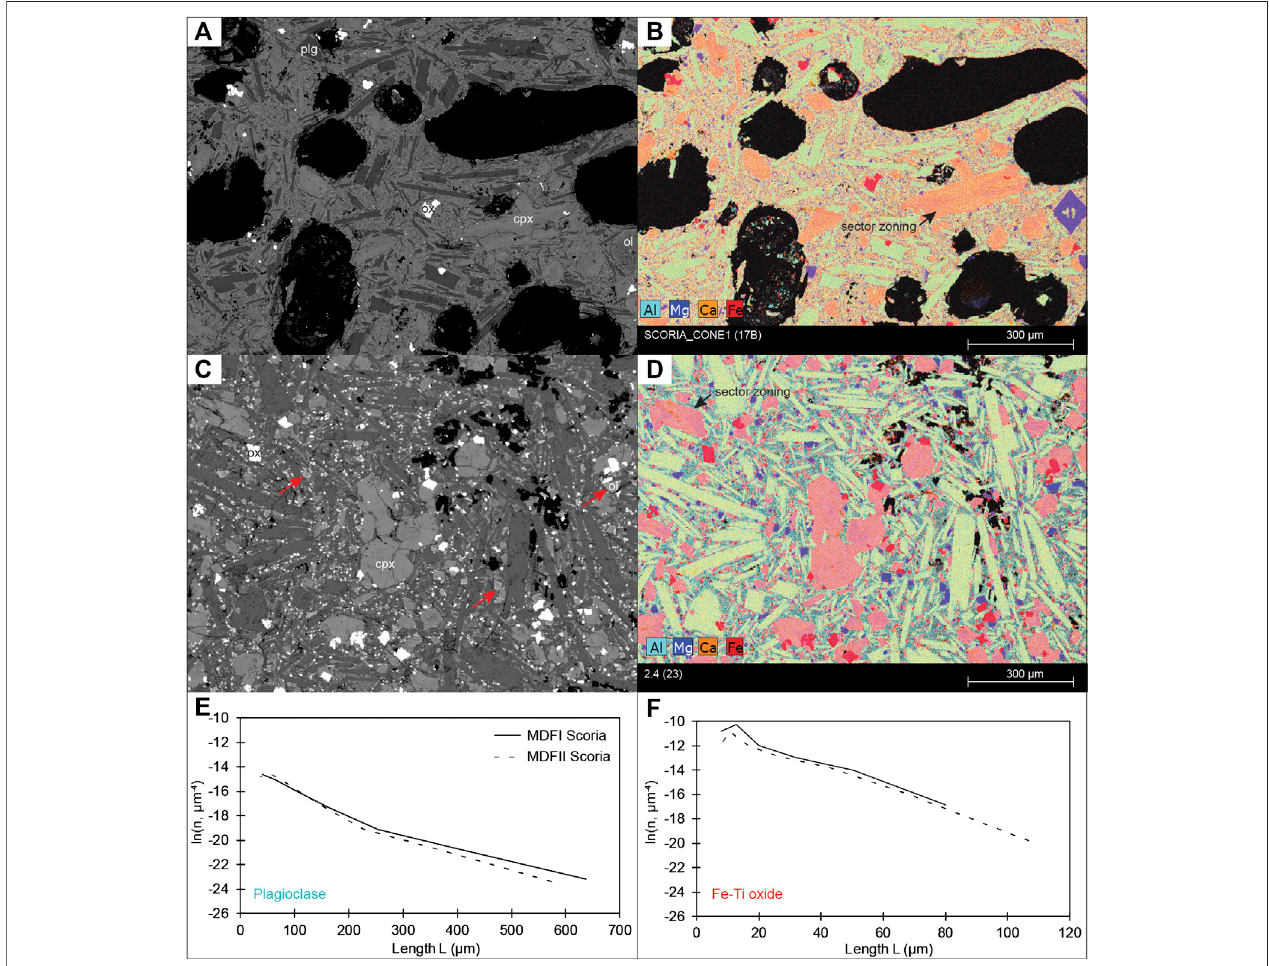
FIGURE7| Back-scatteredelectron imagesandelementmapsoftwoeruptive productsfromthe1974 fl ankeruptionsofMt.Etna: (A , B) ascoriafromthePhaseI (sample#17B,cf. Table3 )and (C)(D) alavasamplefromtheventofPhaseII(sample#23,cf.Table3).Notethathourglasssectorzoningoccursinclinopyroxenes(cpx). Also, note that Phase II lavas contain more Ti-magnetites than those of Phase I, as well as Fe-rich rimmed olivine crystals (red arrows), which are inexistent in Phase I lavas. Plg, ox, cpx and ol respectively stand for plagioclase, oxide, clinopyroxene and olivine. Comparisons of the size distributions of plagioclase (E) and Fe-Ti oxides (F) for both phases. Note that CSDs were generated from the same number of images from each phase in which 946 plagioclases and 335 oxides were considered for Phase I and 1,028 plagioclases and 668 oxides were considered for Phase II. The 3D shape factors determined using CSDSlice (Morgan and Jerram, 2006) returned best level of fi ts of R 2 (cid:2) 0.82 and R 2 (cid:2) 0.94 for plagioclases of each phase and R 2 (cid:2) 0.81 and R 2 (cid:2) 0.88 for oxides of each phase.